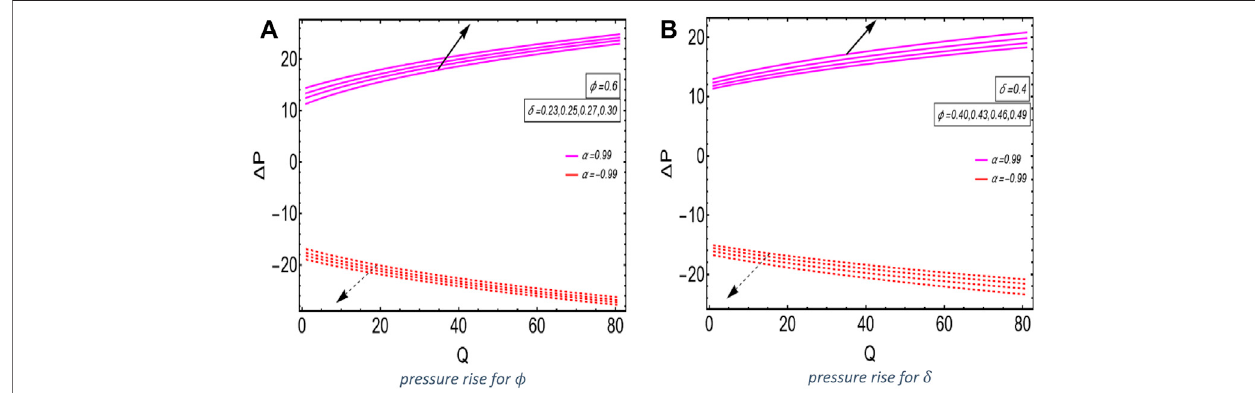
FIGURE 5 | (A) Pressure rise for ϕ . (B) Pressure rise for δ